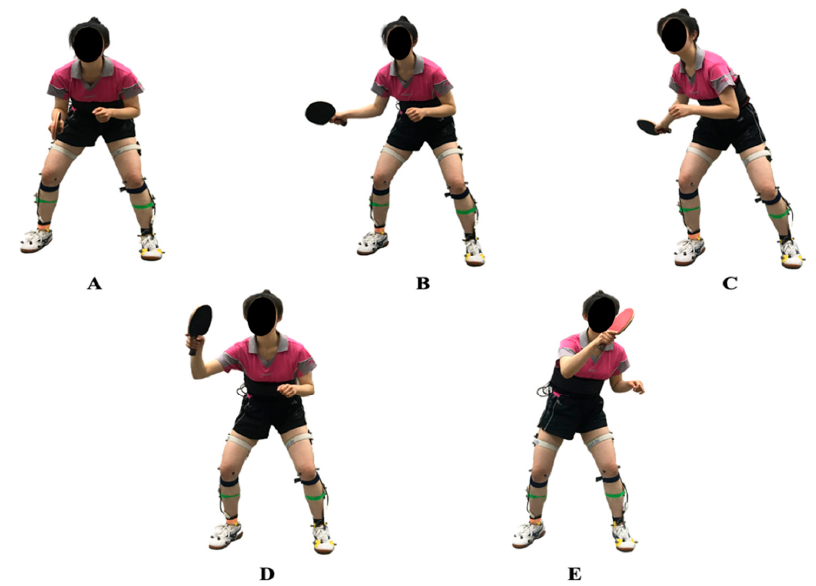
Figure 2. The division and definition of the motion phase. The motion phase ( A ) was defined as the natural position (NP). ( B , C ) The backward swing (BS) phase during the chasse step. ( D , E ) The forward swing (FS) phase during the chasse step. This research focused on the key event of the entire motion cycle of the chasse step, so we defined position C as the event that defined the end moment of the backward phase (BP). Position E was defined as the key event that identified the end moment of the forward phase